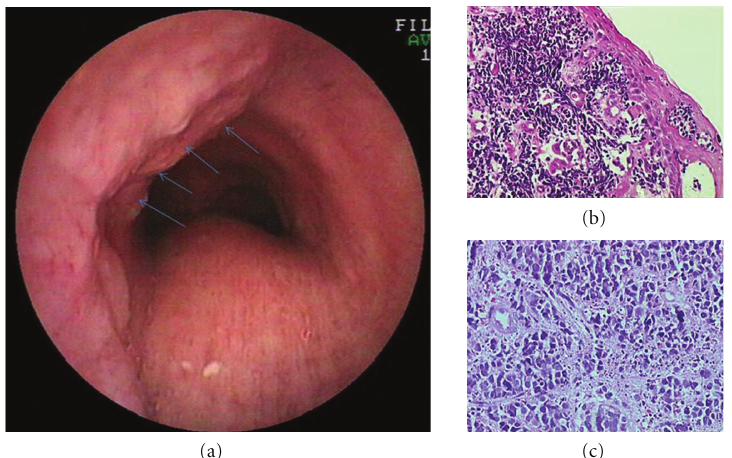
Figure 2: (a) Bronchoscopic exploration showed submucosal tumoral infiltration at the left anterolateral wall of trachea (arrows). (b, c) Biopsy materials are shown in the histopathologic